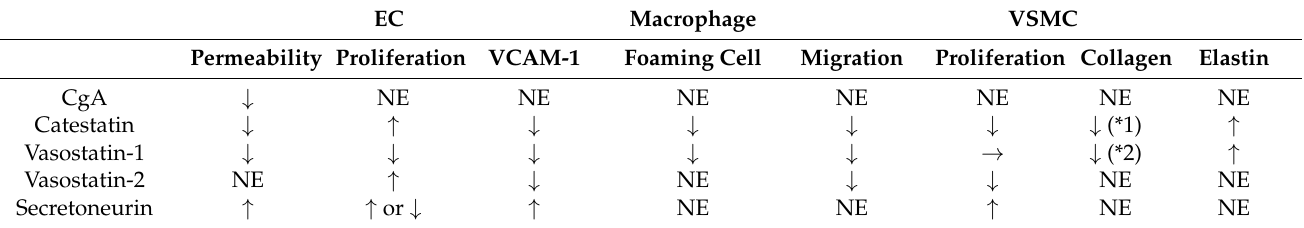
Table 3. Effects of CgA, catestatin, vasostatin-1, vasostatin-2, and secretoneurin on vascular cell responses for